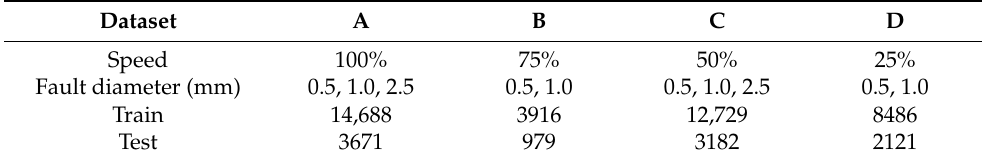
Table 7. Description of the actual